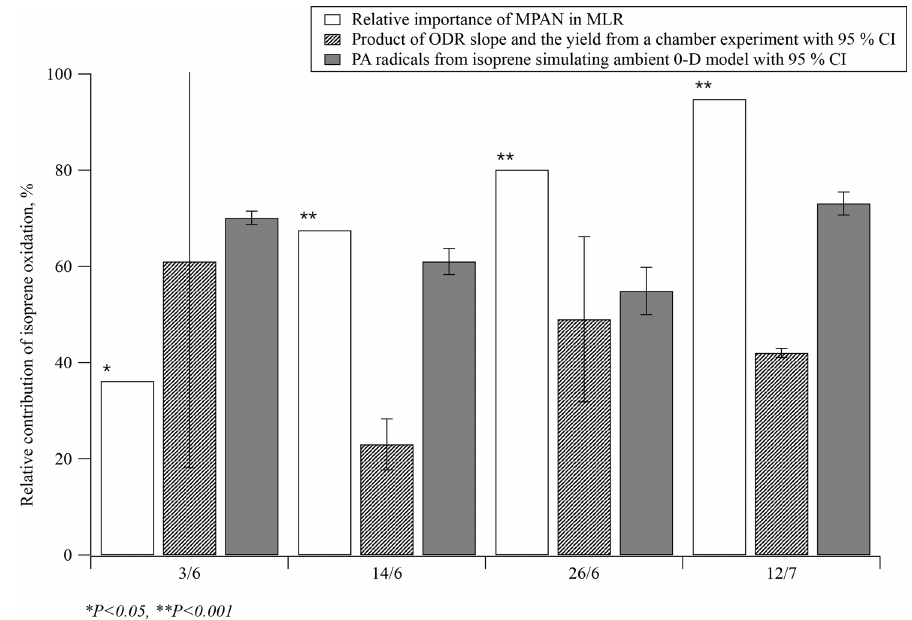
Figure 5. Estimates of the relative contribution of isoprene oxidation to PAN formation during four specific days of SOAS 2013 using three different approaches: multiple regression analysis, ODR with chamber data, and simulation of PA radicals using a 0-D model. P indicates the calculated probability of the t test; CI = confidence